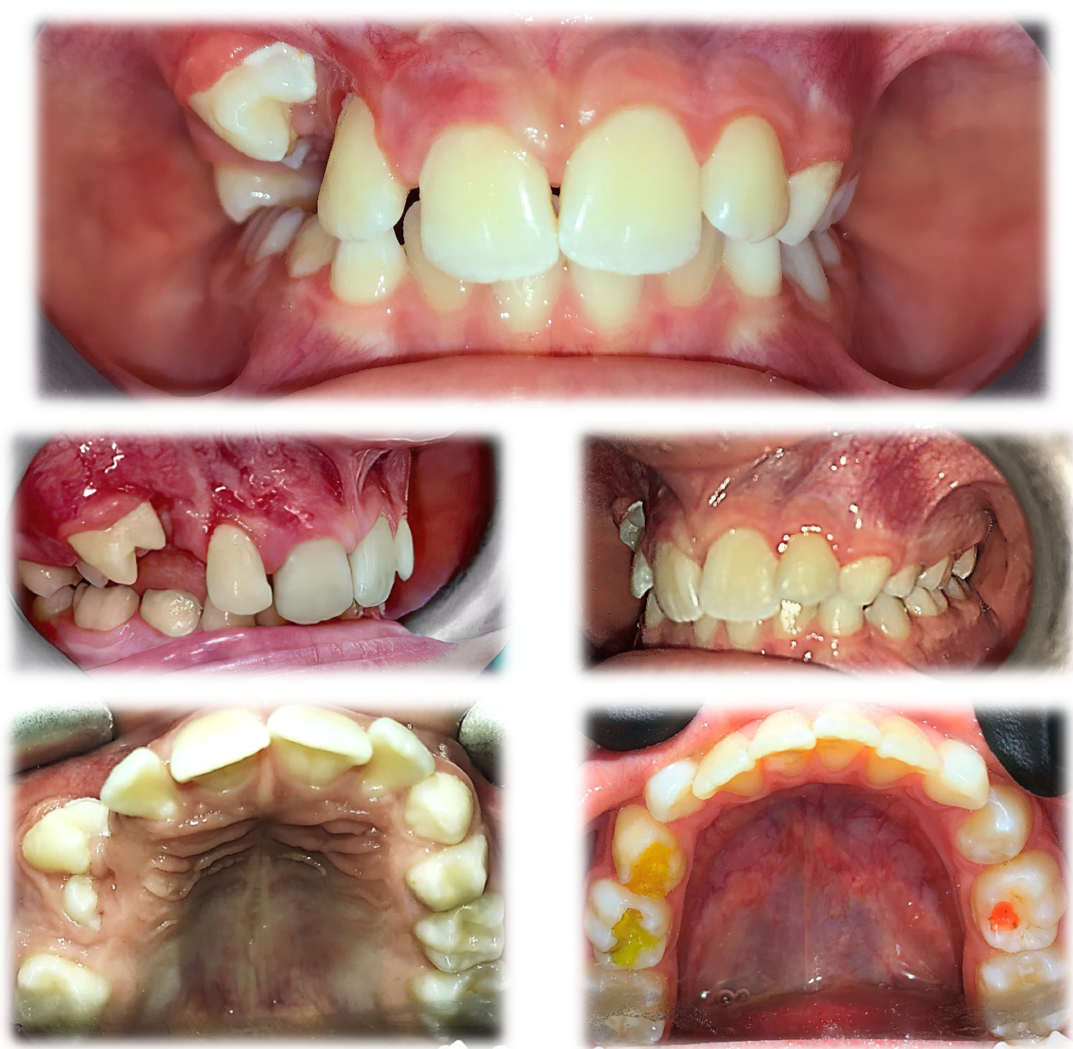
Figure 2. Intraoral photographs before treatment.